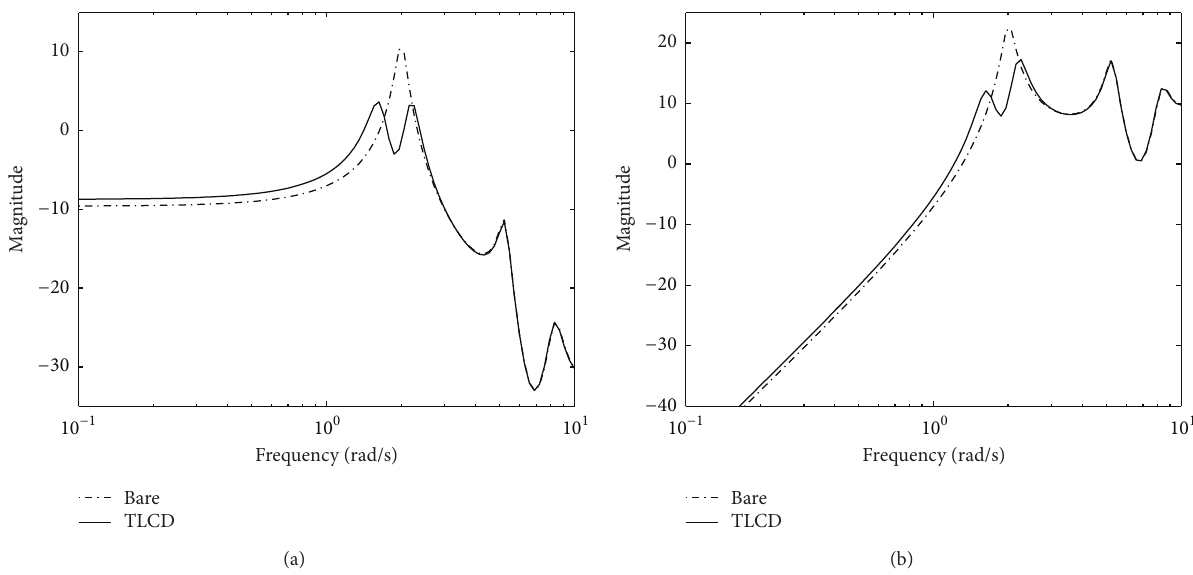
Figure 6: Frequency response curve comparisons: (a) frequency response for displacement; (b) frequency response for